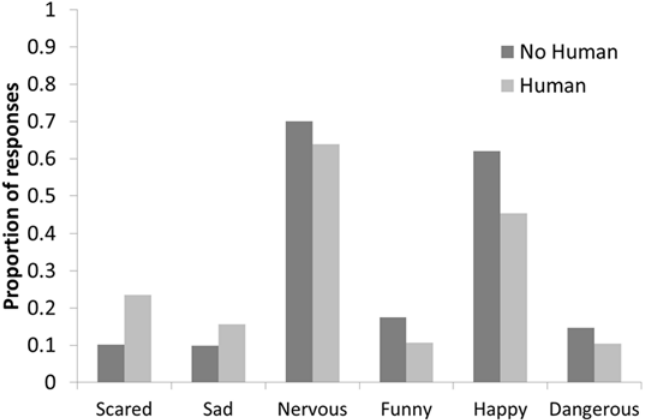
Fig 1. The proportion of respondents who described the primate using the trait when presented with a photo of the primate with or without a human present, averaged across the natural and office settings.